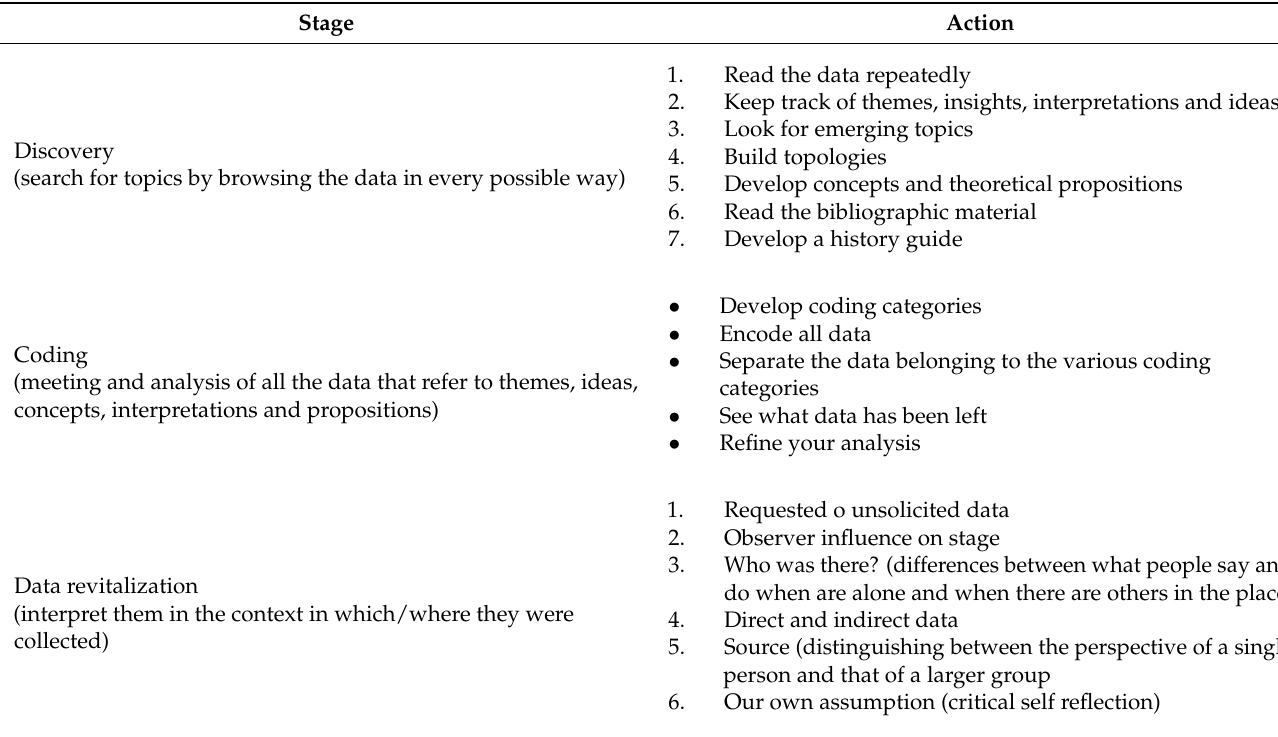
Table 1. In-process analysis approach in qualitative research